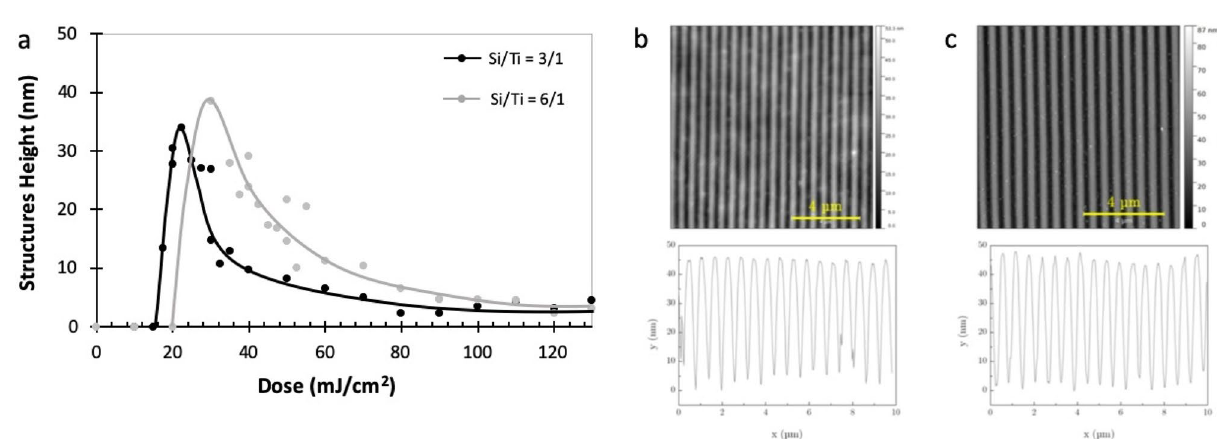
Figure 9. ( a ) Variation of the pattern height with the dose for two content of Ti complex in the material: Si/ Ti = 3/1 and 6/1 molar. Initial film thickness was 80 nm, period 500 nm, MNP: 0.4 vol%. ( b ) and ( c ) are AFM images of the patterns for the optimal dose, respectively for Si/Ti = 3/1 and